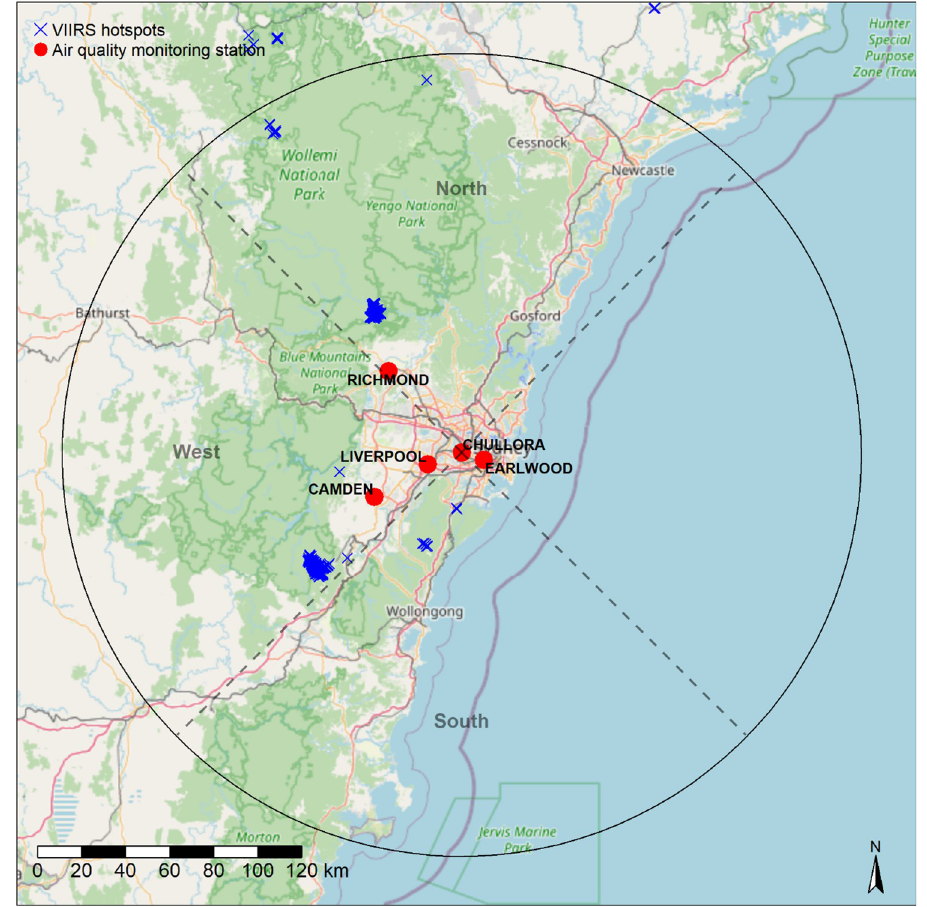
Fig 1. Study area map showing air quality monitoring stations used in analysis and example of VIIRS SNPP hotspots for one day and night between 2019-04-28 midday and 2019-04-29 midday. 150 km buffer around Chullora is black circle. West, South and North region were used for calculating separate fire area variables. Basemap: © OpenStreetMap